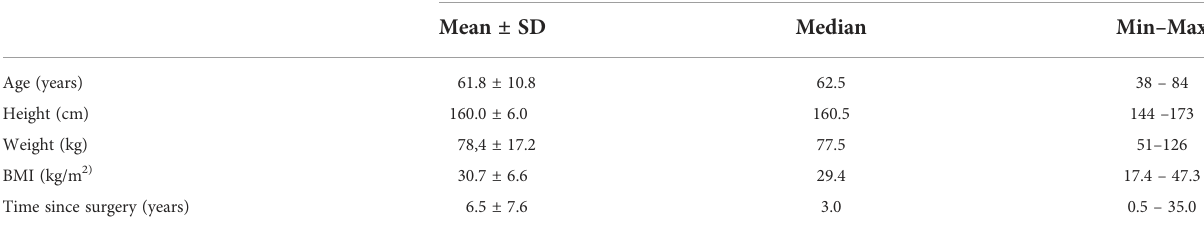
TABLE 1 Characteristics of the participants.